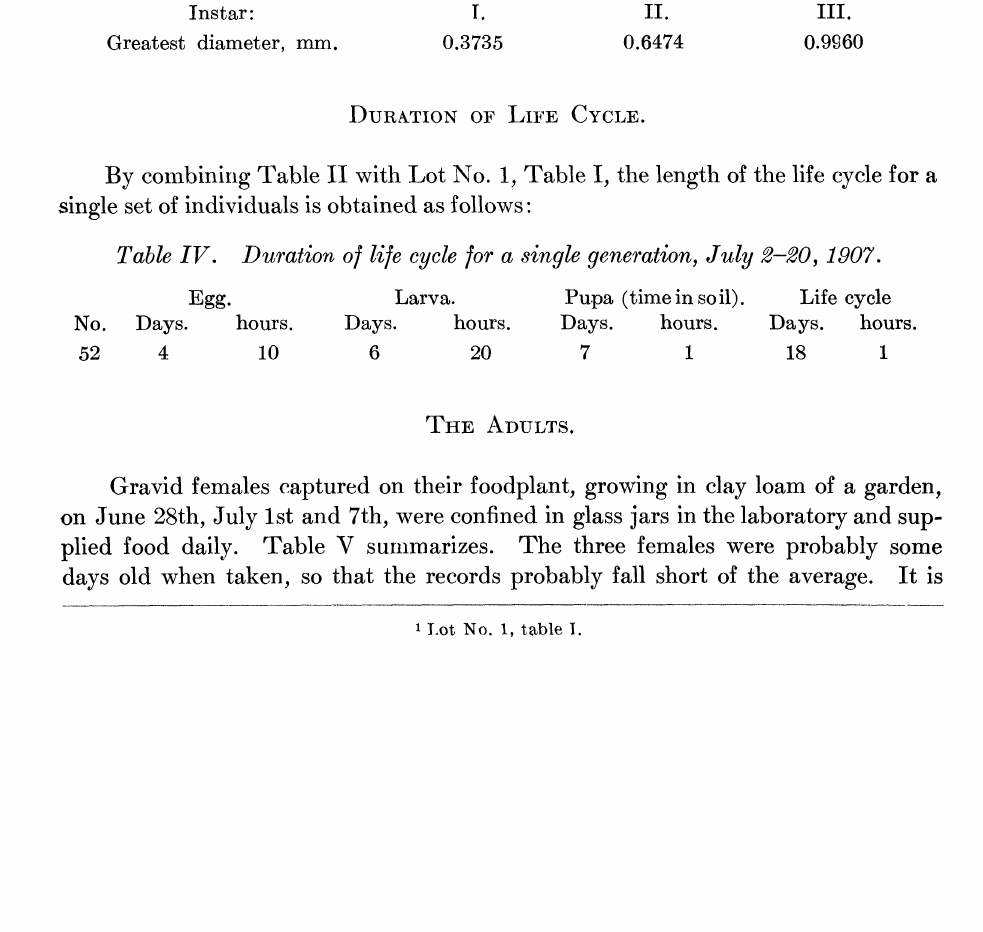
Table III. A v. Width o] the Head ]or Respective Larval Instars. Instar: